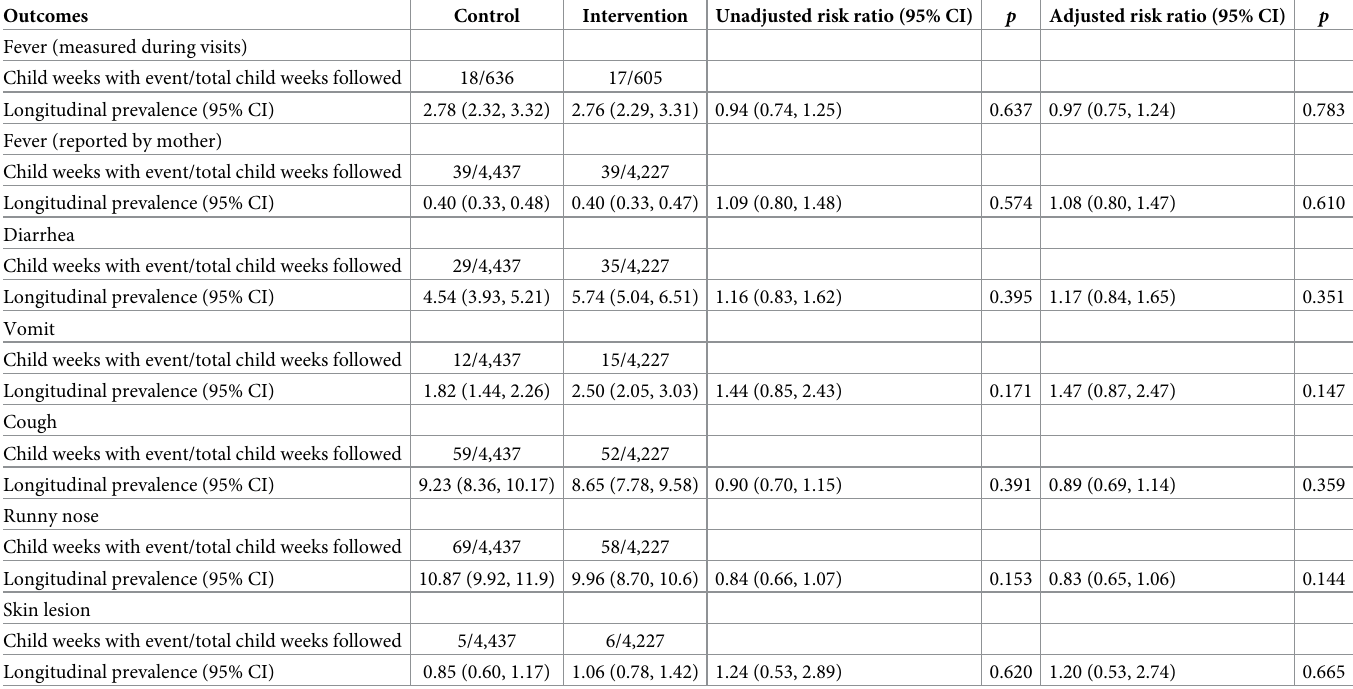
Table 6. Effect of maternal prenatal BEP supplementation on infant morbidity during the 6 months postpartum follow-up 1